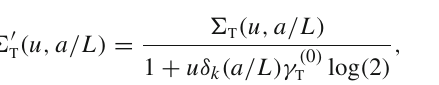
Table 13 N f = 2 results for the renormalization constant Z ( L g 2 SF